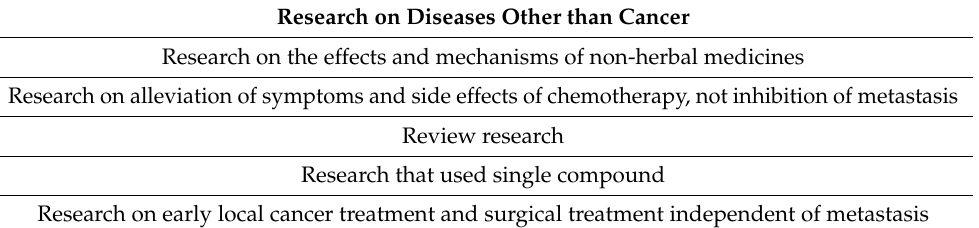
Table 1. Exclusion